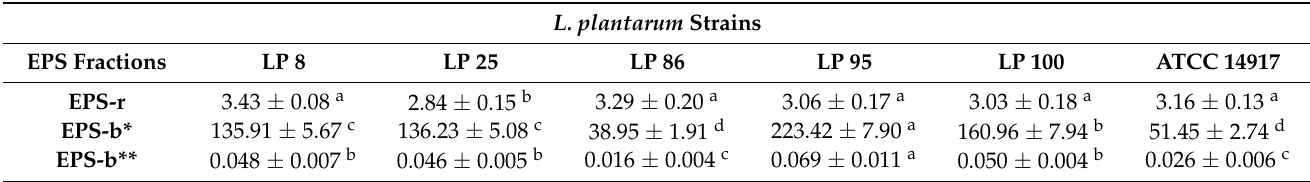
All values are expressed as mean ± standard deviation ( n = 3). Different lowercase letters (a–d) in each row indicate significant differences ( p < 0.05).